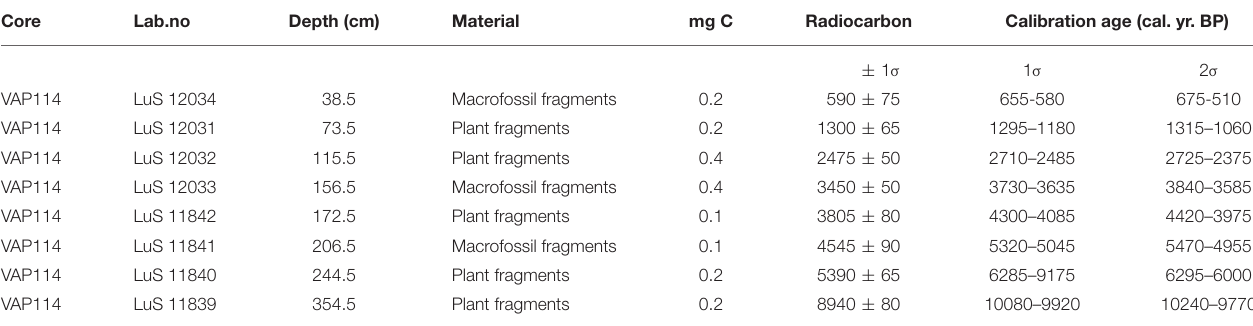
TABLE 2 | Results from radiocarbon dating of macrofossil remains from selected intervals in VAP114.